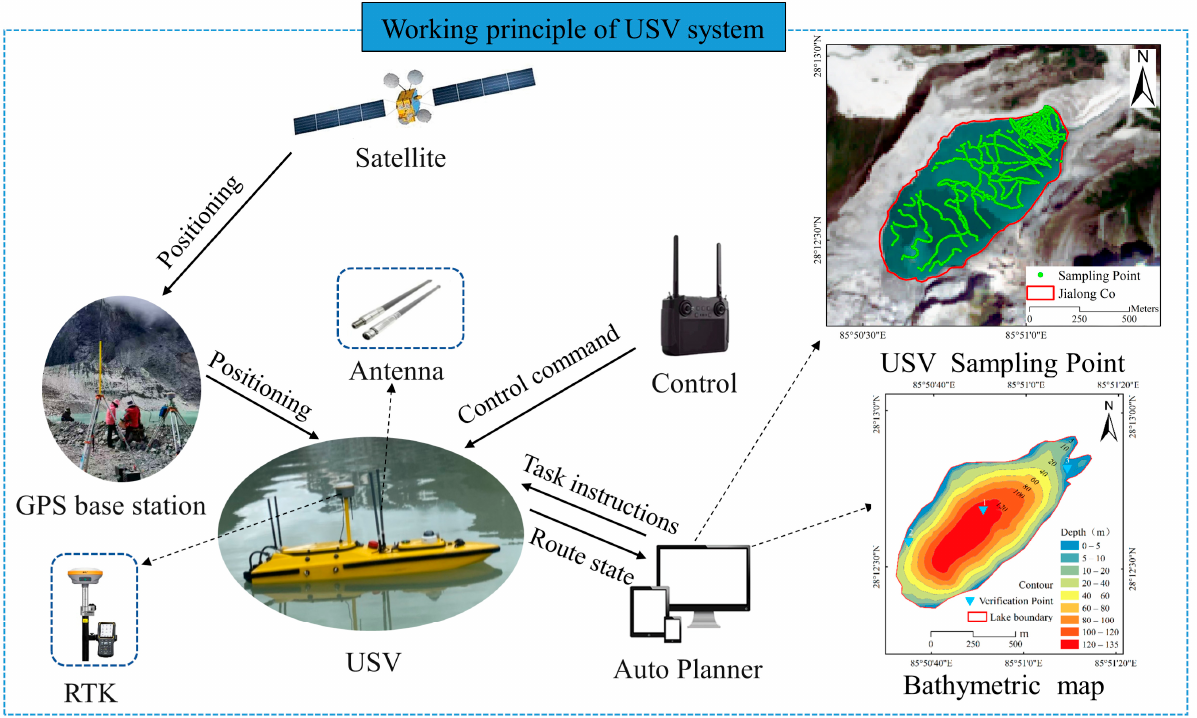
Figure 5. Working principle of the USV bathymetry system.